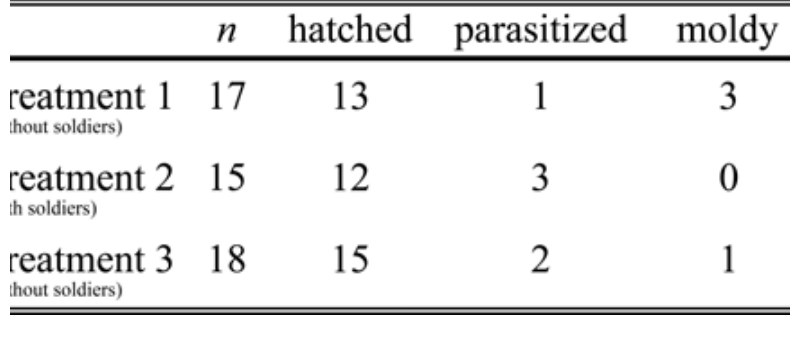
Table 1: Numbers of hatched and dead A. ignipicta eggs among the three